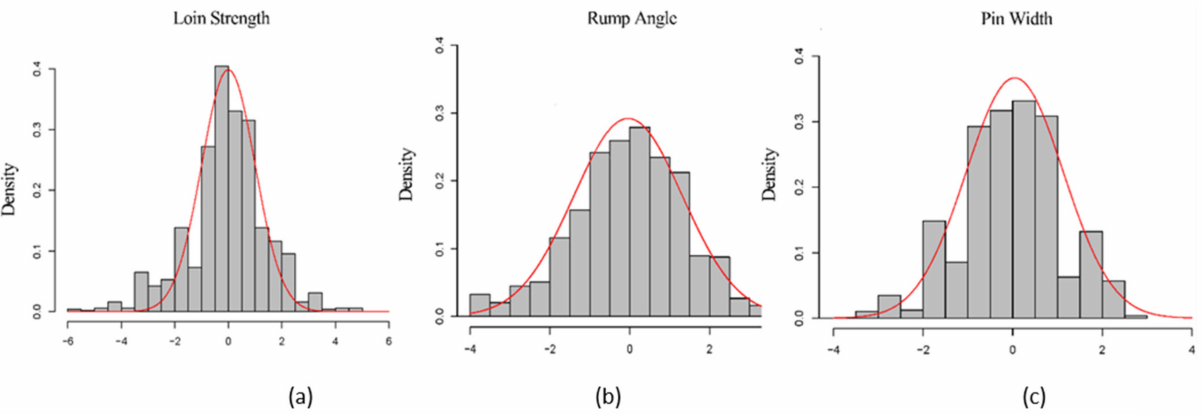
Figure 2. Frequency distribution of the adjusted phenotypes of Loin Strength ( a ), Rump Angle ( b ), and Pin Width (PW) ( c ), of the population in this study. The adjusted phenotypes of the three traits all presented approximately normal distributions. Table 1. Descriptive statistics for adjustment of LS, RA, and PW of cows; n = 984.